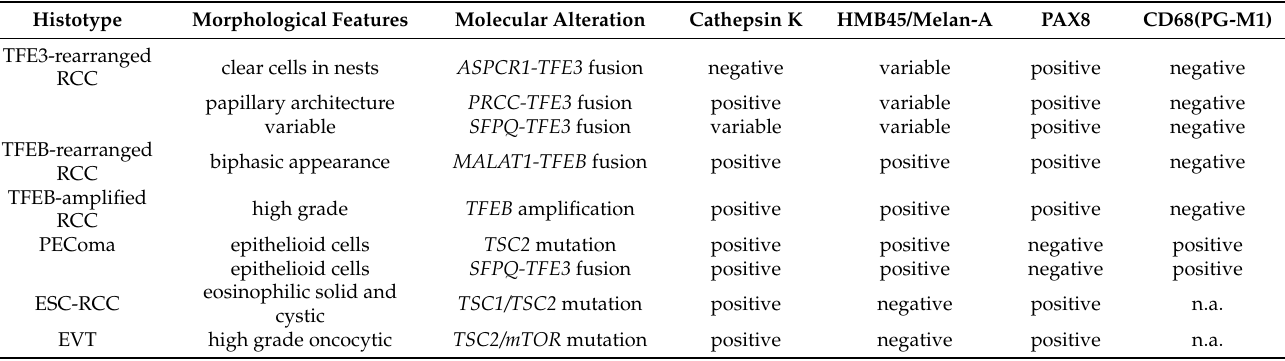
Table 2. Renal tumors with expression of cathepsin